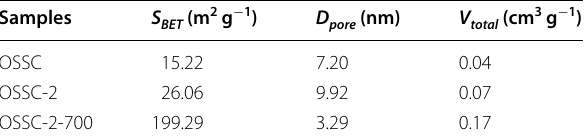
Table 2 Pore structural parameters of OSSC, OSSC-2 and OSSC-